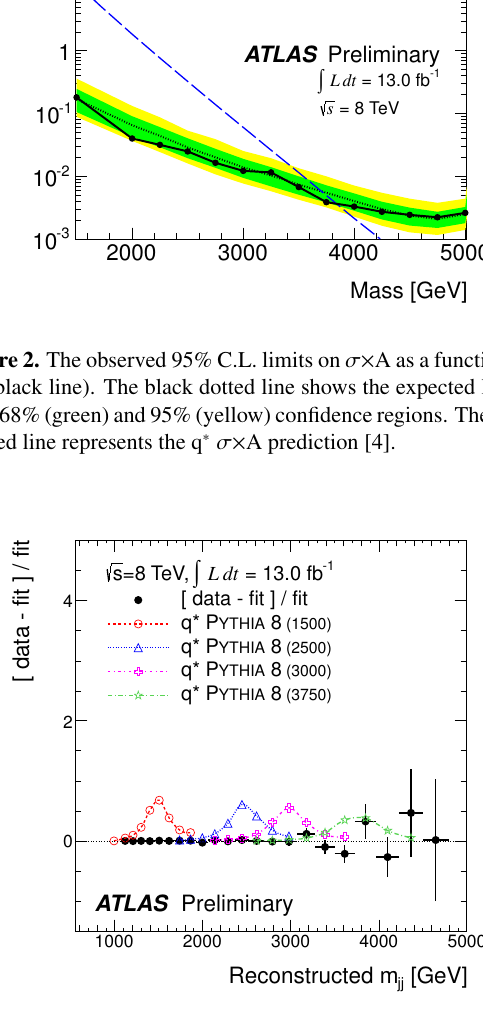
Figure 3. Four q ∗ templates normalized to the background fit and compared to data